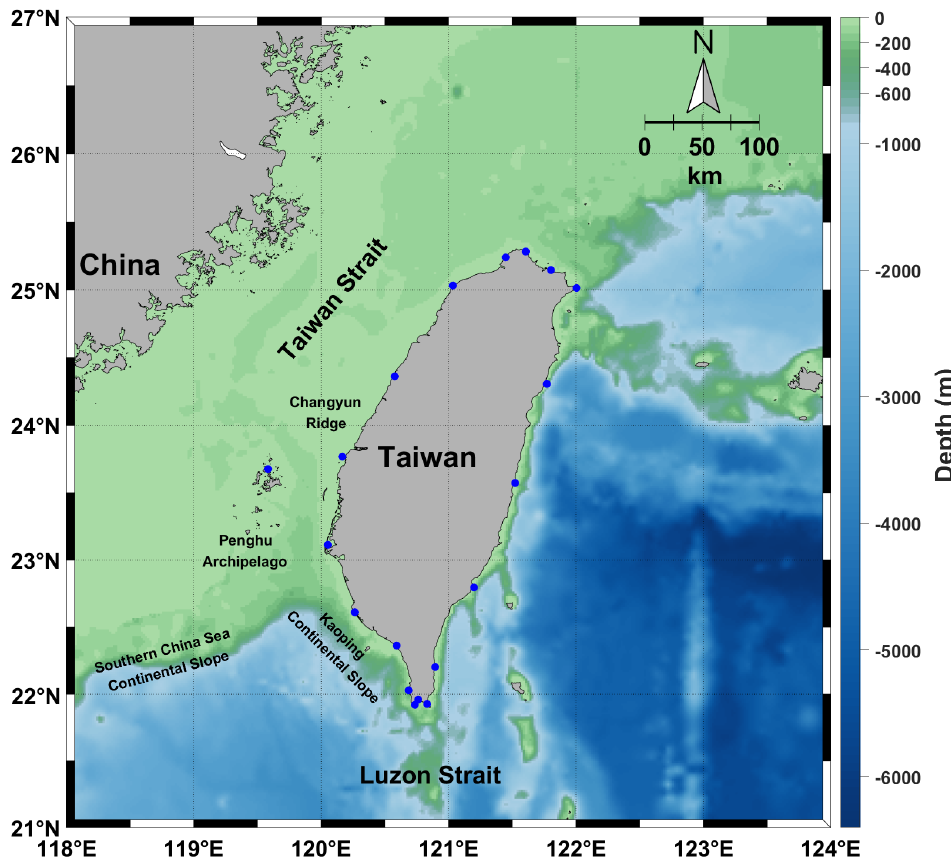
Figure 1. The study area and locations of Taiwan’s CODAR system (blue dots).